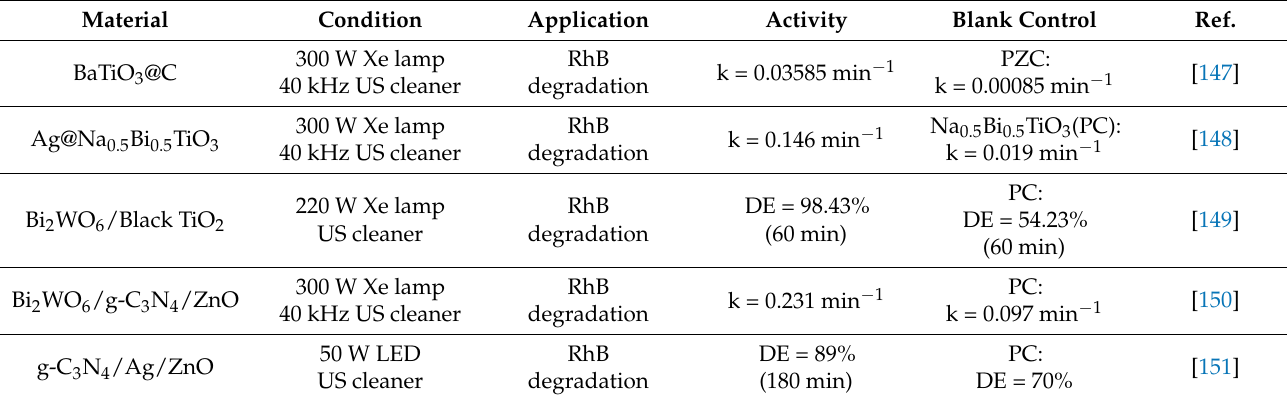
Table 2. Summary of mechanical-coupled photocatalysis in recent